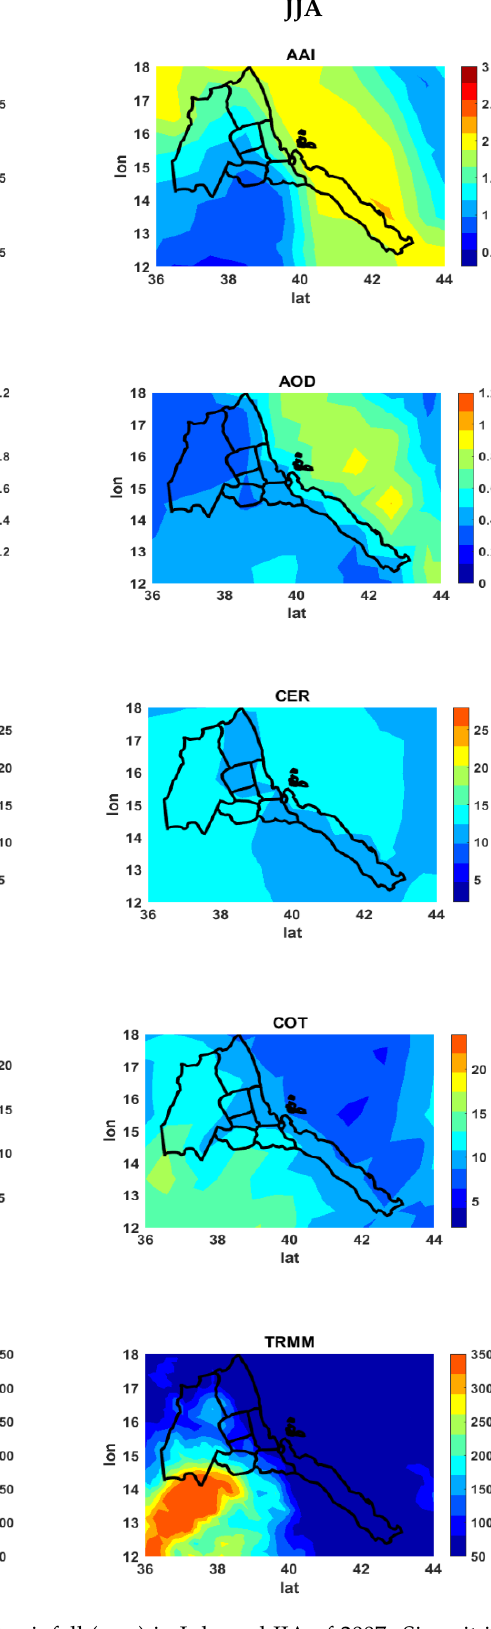
Figure 4. ( a ) AAI, ( b ) AOD, ( c ) CER ( µ m), ( d ) COT, and ( e ) rainfall (mm) in July and JJA of 2007. Since it is a normal monsoon year, the aerosols, cloud characteristics, and rainfall of 2007 are shown.